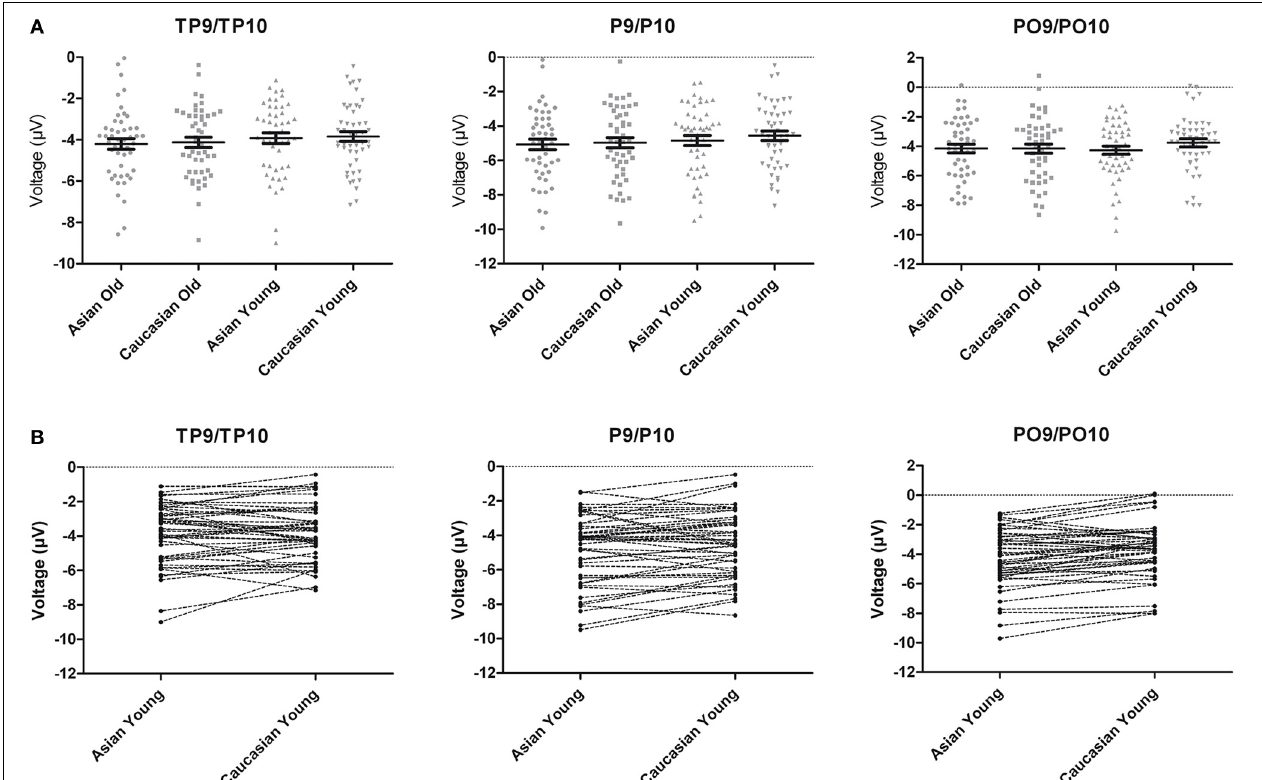
FIGURE 3 | (A) Scatter plots depicting N170 amplitude averaged across left and right hemispheric occipito-temporal sites. Horizontal lines reflect mean N170 amplitudes, error bars denote standard errors of the mean.